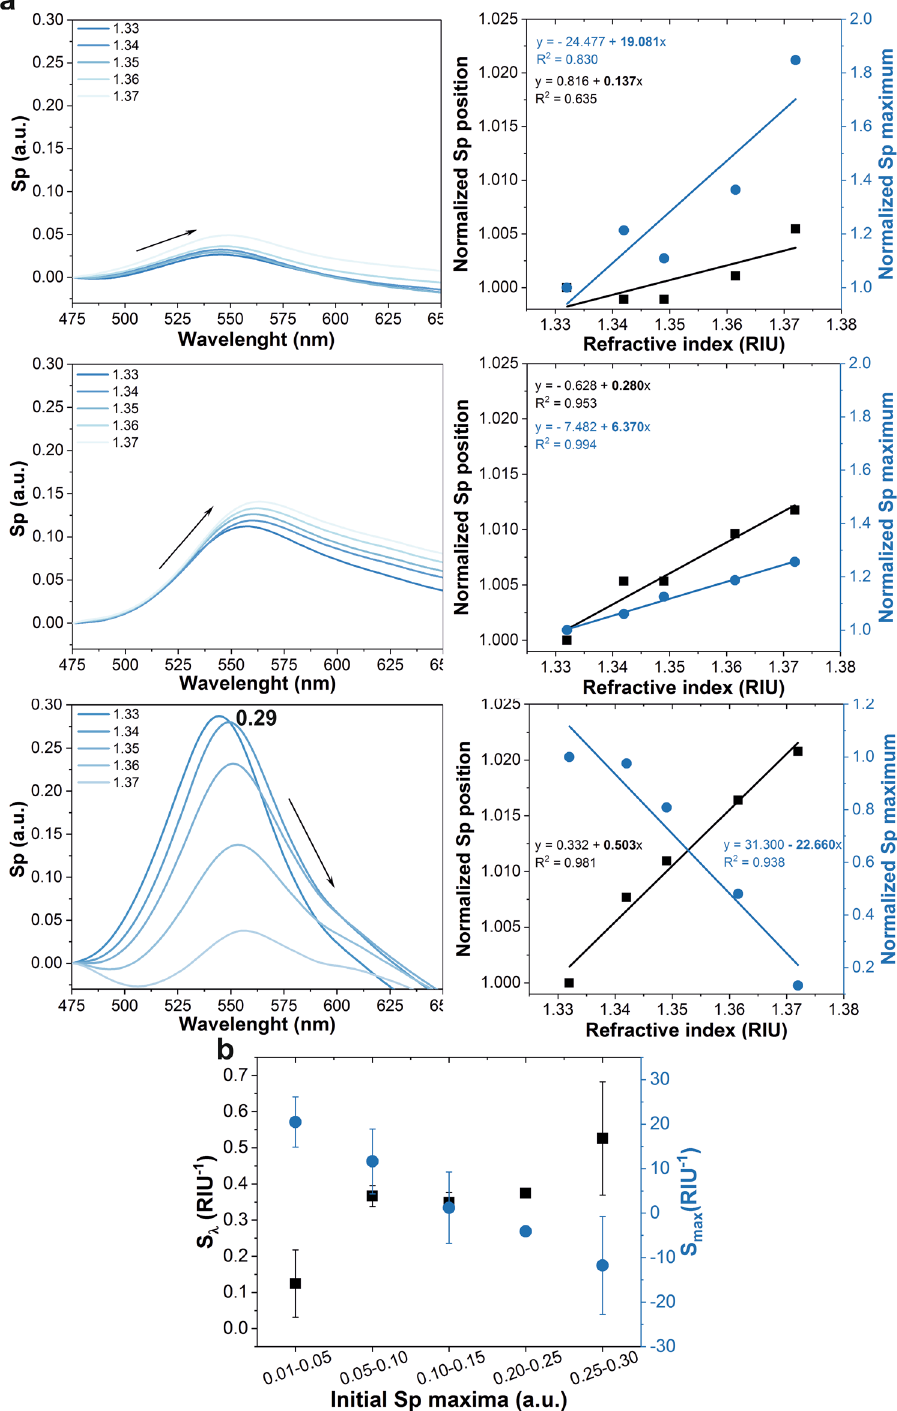
Figure 5. Sensitivity to changes in the refractive index of probes with different initial Sp maxima. ( a ) Examples of the performance of fibers with initial Sp maxima of 0.03, 0.11 and 0.29 a.u. On the right column, the evolution of the normalized wavelength position and value of the Sp maxima upon exposure to increasing RI solutions. ( b ) S λ and S max values obtained from the slopes of the linear regressions of the results from fibers with different initial Sp maxima. The measured fibers were grouped in five sets according to their range of initial Sp maximum values. Error bars correspond to the standard deviation between the fibers in each set (n = 4, except for the range of 0.2 to 0.25 a.u., with only one